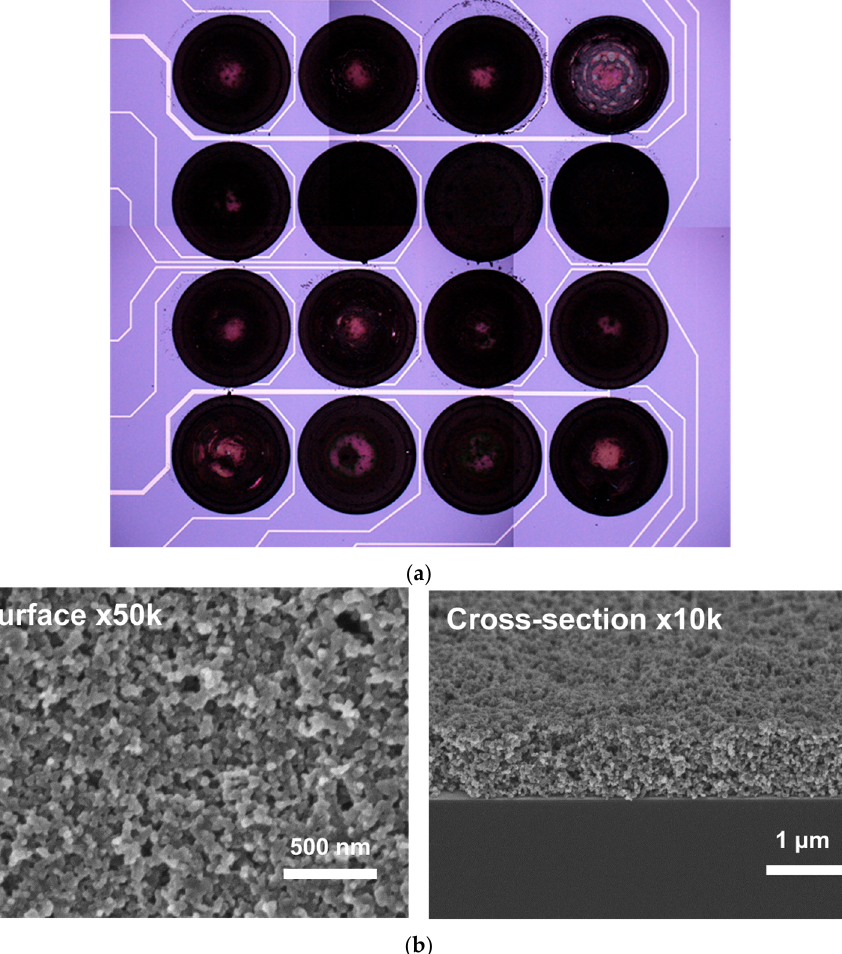
Figure 9. Microscopic images of a 16-channel chemosensitive resistor device: ( a ) optical microscope image of the whole device; ( b ) scanning electron microscopy (SEM) images of surface and cross section of the carbon black—PEG4000 composite film.